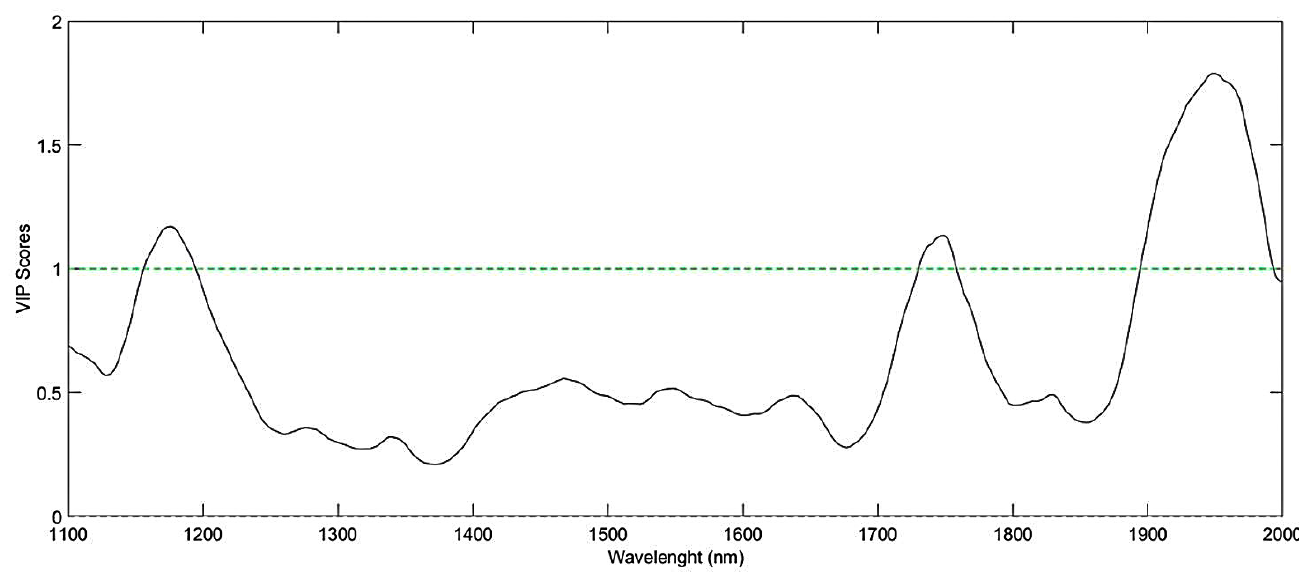
Figure 6. VIP Scores of the PLS models based on NIR data.